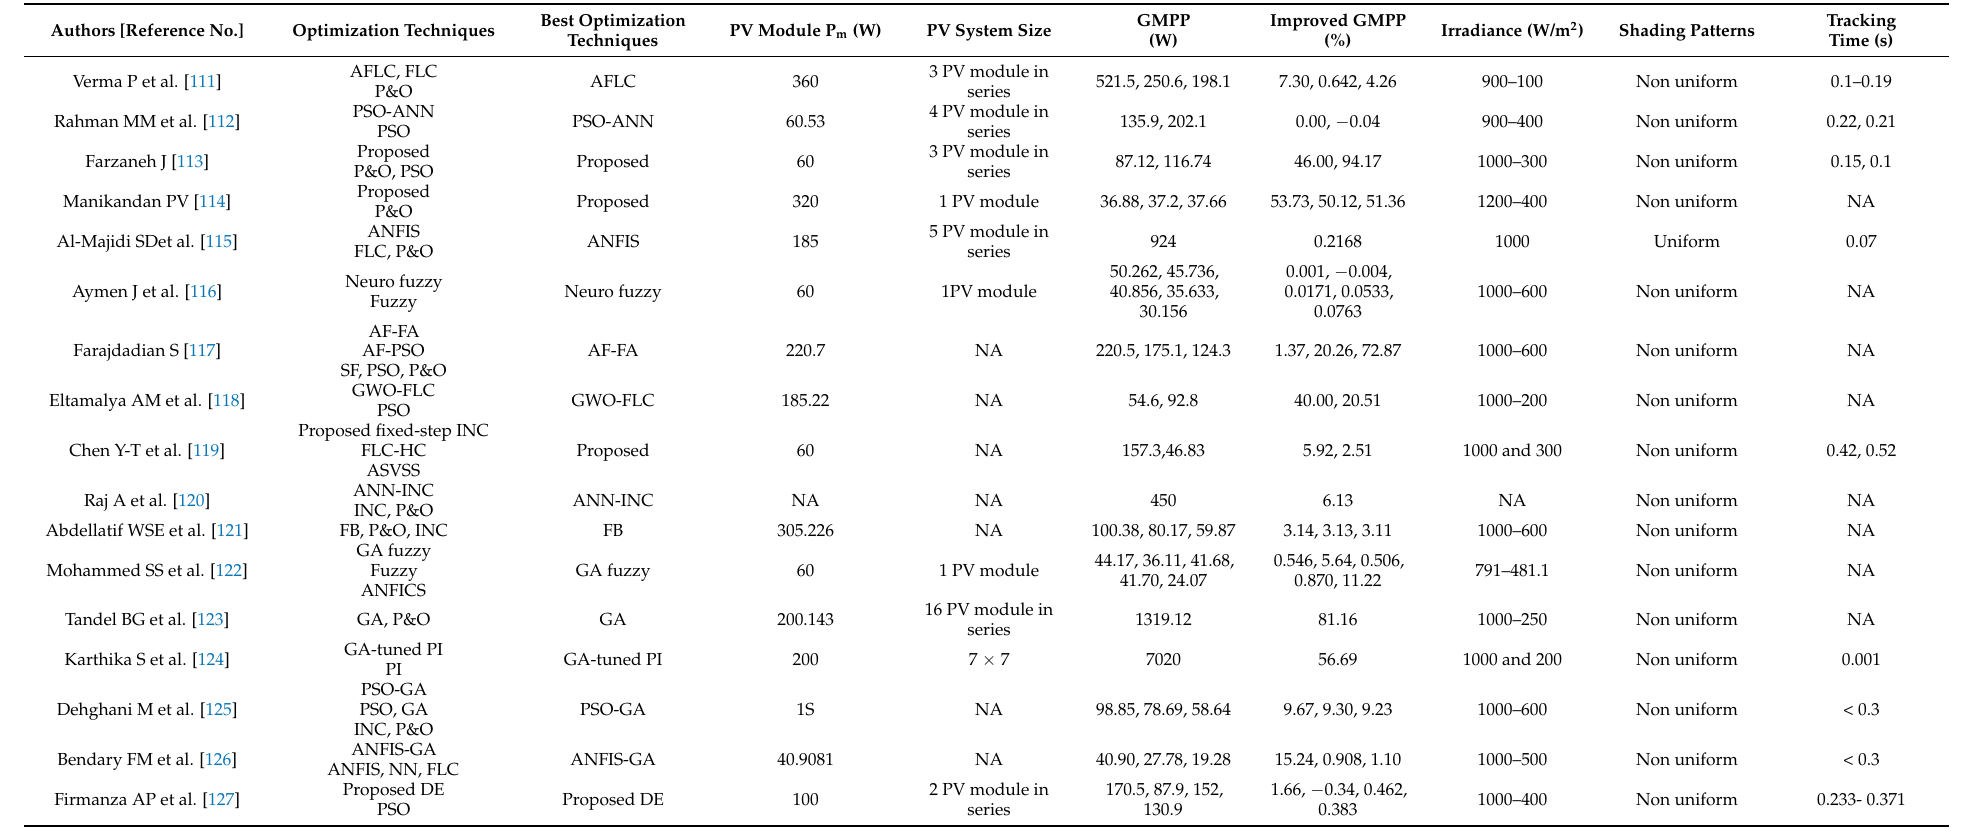
Table 7. Taxonomy on recent reported work on other artificial intelligence techniques to track